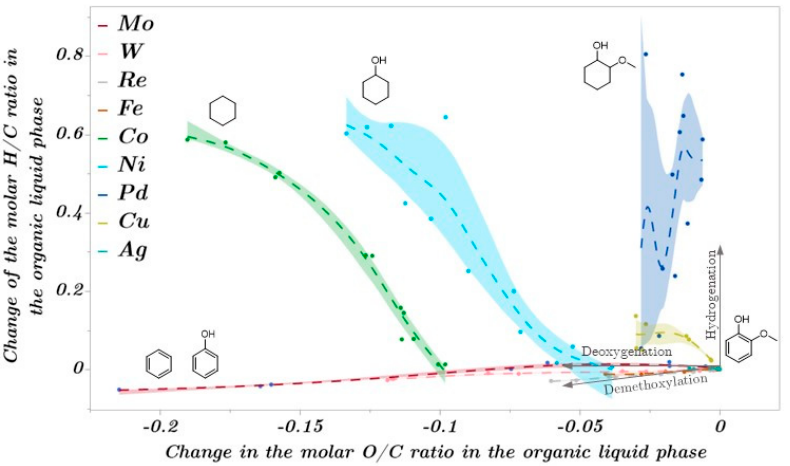
Figure 15. Pseudo van Krevelen diagram: Change in the molar O/C and H/C ratio in the liquid phase compared to the starting material guaiacol (O/C = 0.29, H/C = 1.14). A negative change in the O/C ratio results from deoxygenation, and a positive change in the H/C ratio results from hydrogenation. The dashed smoothing is based on a spline with λ = 0.05 and the confidence interval is shown as an envelope curve.